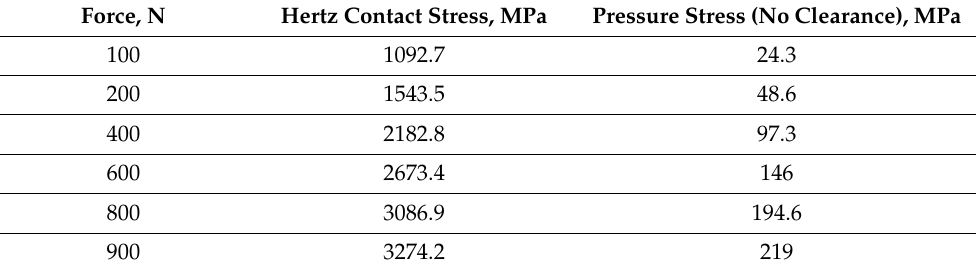
Table 2. Results of the analytical analysis of contact